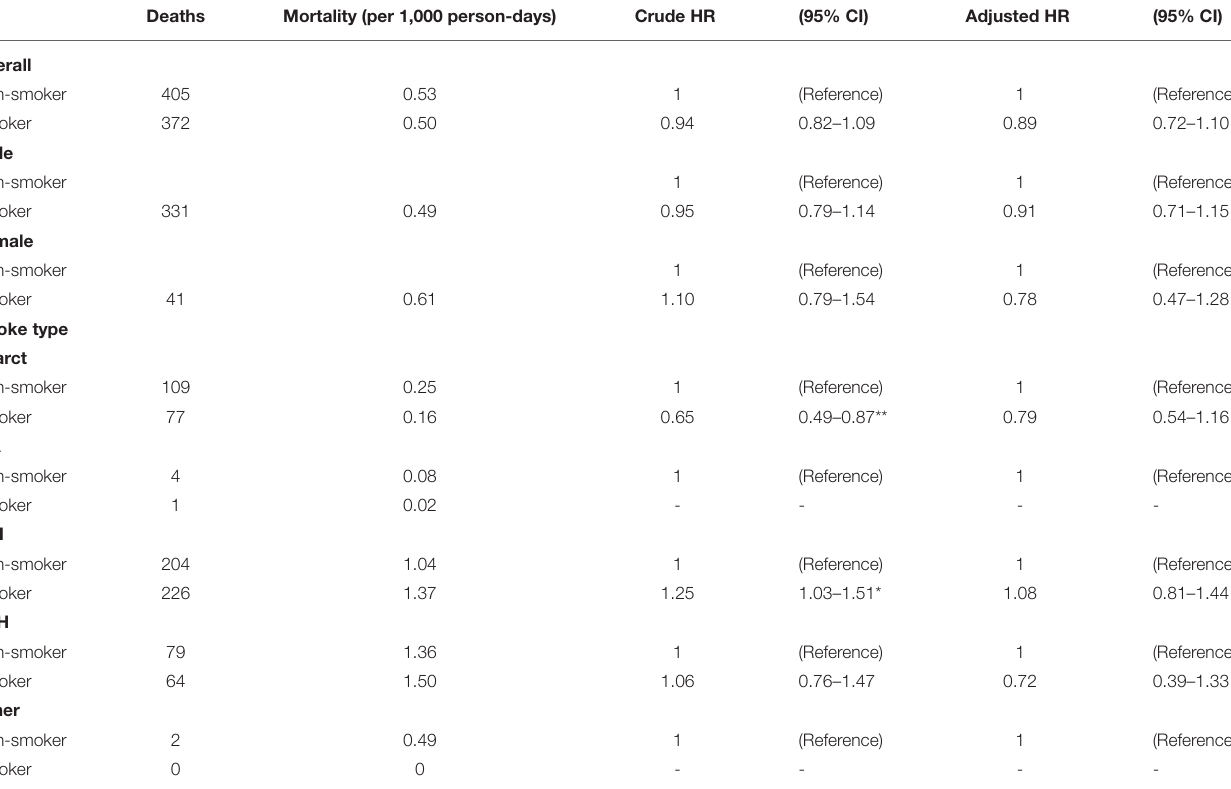
TABLE 2 | Mortality and hazard ratio (HR) for stroke events in smokers compared to non-smokers in all stroke patients. Deaths Mortality (per 1,000 person-days)